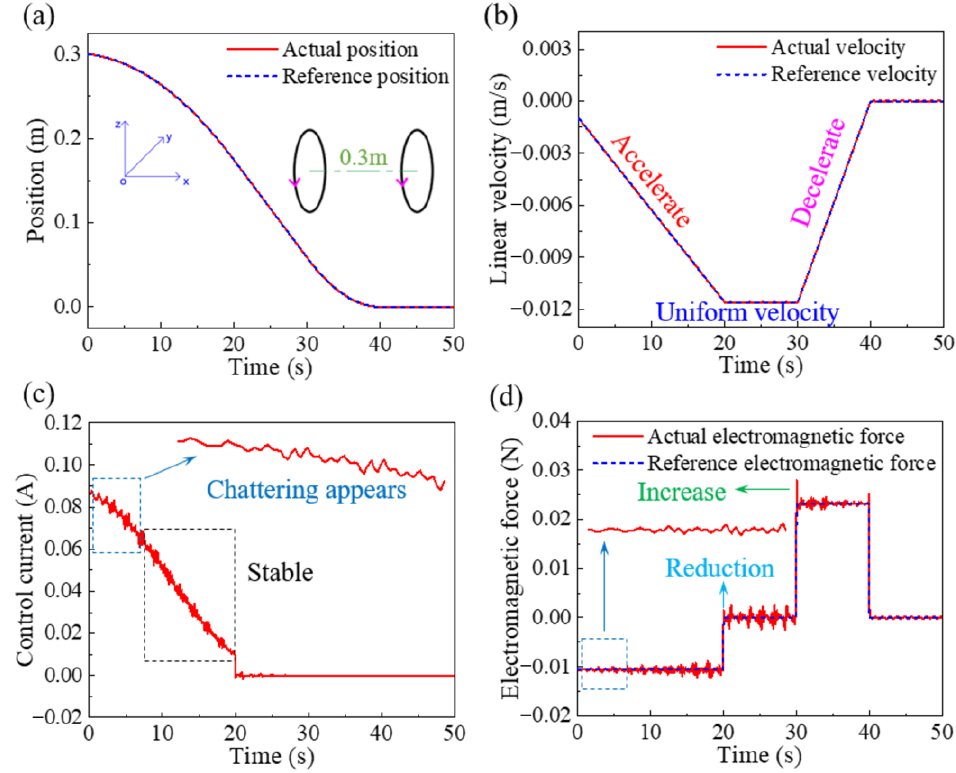
Figure 12. The position ( a ), linear velocity ( b ), control current ( c ), and electromagnetic force ( d ) of the sliding mode control based on the quasi sliding mode with sinusoidal interference.